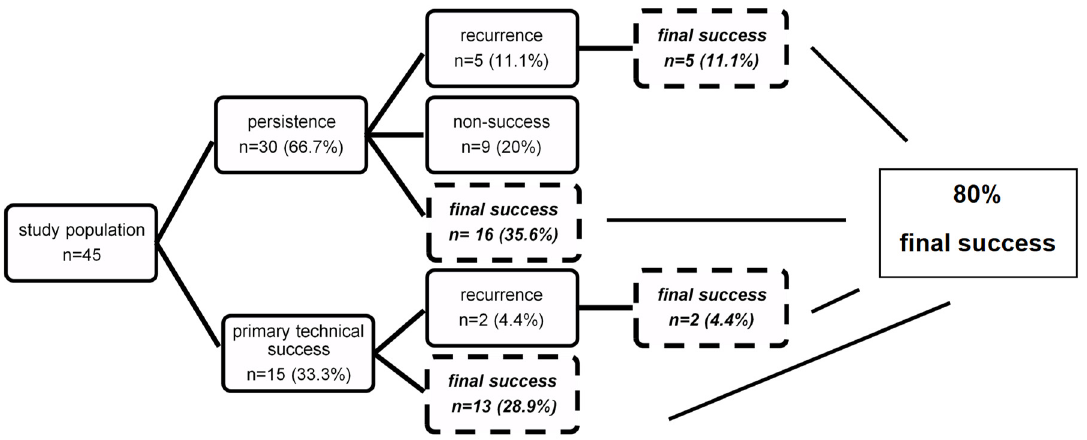
Figure 2. Flow diagram showing success of procedure. Table 5. Surgical outcome.